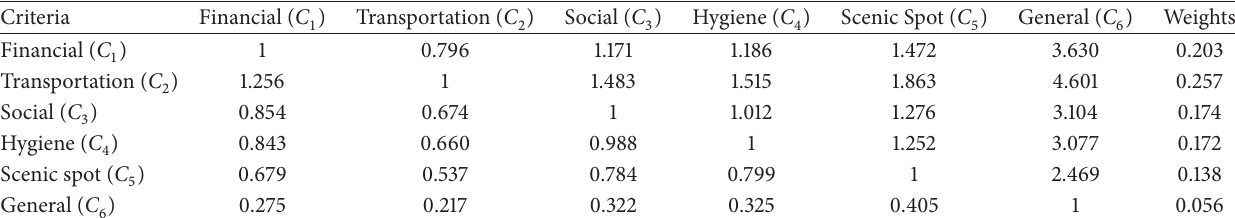
Table 2: Pairwise comparison matrices for criteria of level 2.